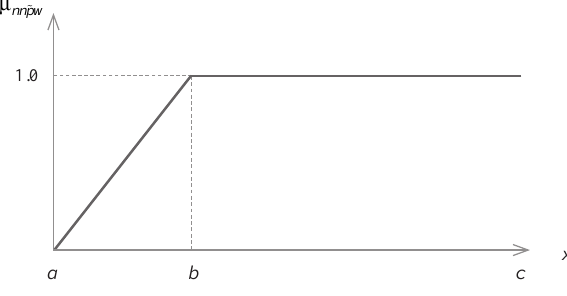
Fig. 7. Membership function of the fuzzy set of a positive NPW